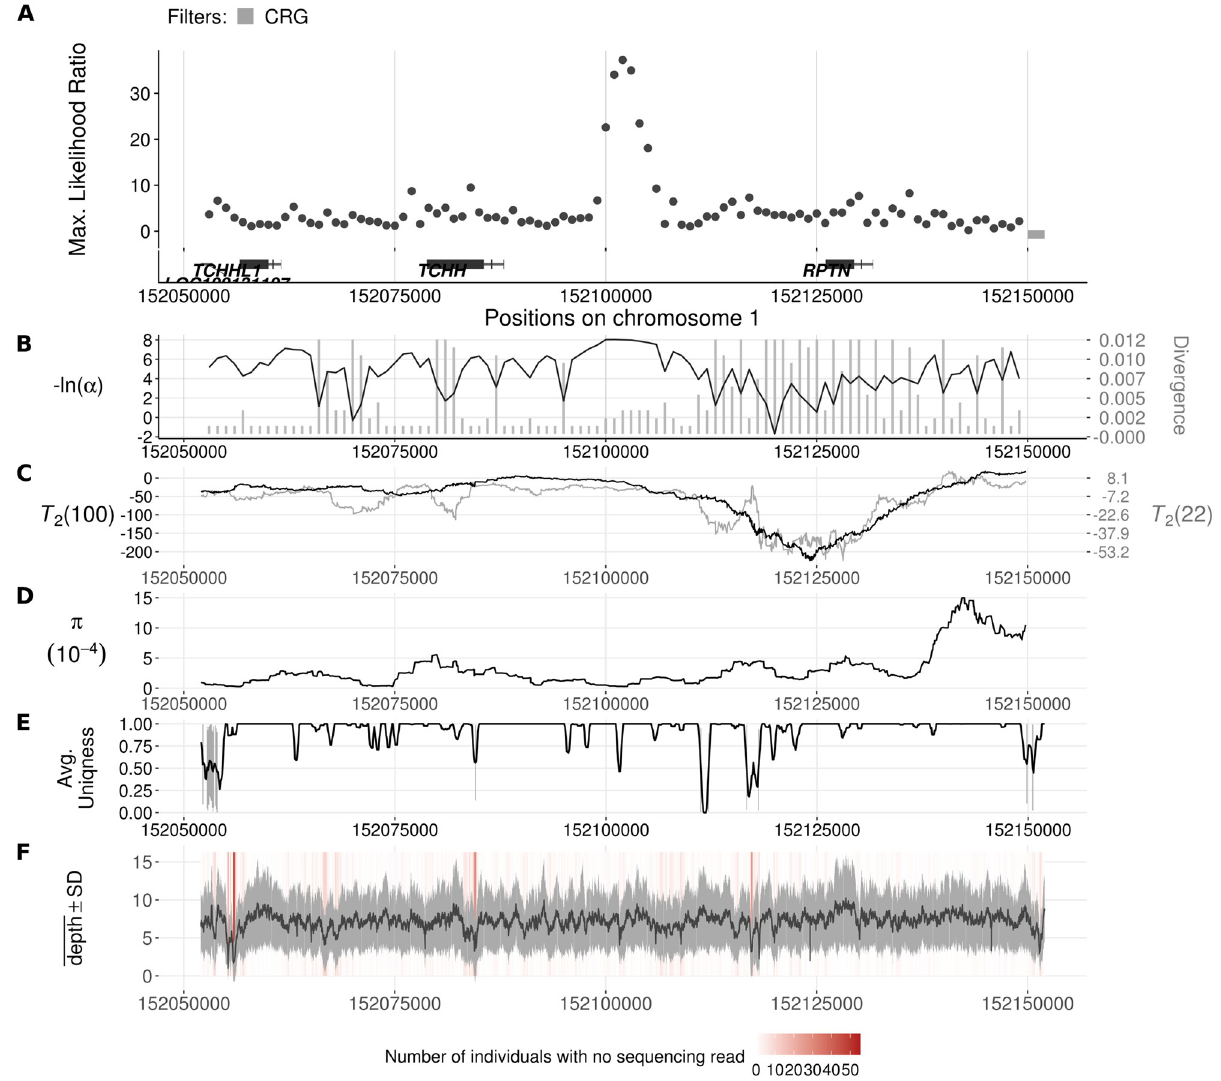
Fig 10. Introgression sweep signals, parameter estimates, and sequencing properties across the 100 kb region on chromosome 1 covering TCHH and RPTN genes in YRI. A . Likelihood ratio test statistic computed from Model 1 of VolcanoFinder on data on within-YRI polymorphism and substitutions with respect to chimpanzee. Horizontal dark gray bars correspond to regions that were filtered based on mean CRG score. Gene tracts and labels for key genes are depicted below the plot, with the wider bars representing exons. B . Values for α and divergence D corresponding to the maximum likelihood estimate of the data. Black line corresponds to − ln( α ) and vertical gray bars correspond to estimated D . C . Likelihood ratio test statistic computed from T 2 of BALLET on data on within-YRI polymorphism and substitutions with respect to chimpanzee using windows of 100 (black) or 22 (gray) informative sites on either side of the test site. D . Mean pairwise sequence difference ( ^ y ) computed in five kb windows centered on p each polymorphic site. E . Mappability uniqueness scores for 35 nucleotide sequences across the region. F . Mean sequencing depth across the 108 YRI individuals as a function of genomic position, with the gray ribbon indicating standard deviation. The background heatmap displays the number of individuals devoid of sequencing reads as a function of genomic position, with darker shades of red indicating a greater number of individuals with no sequencing